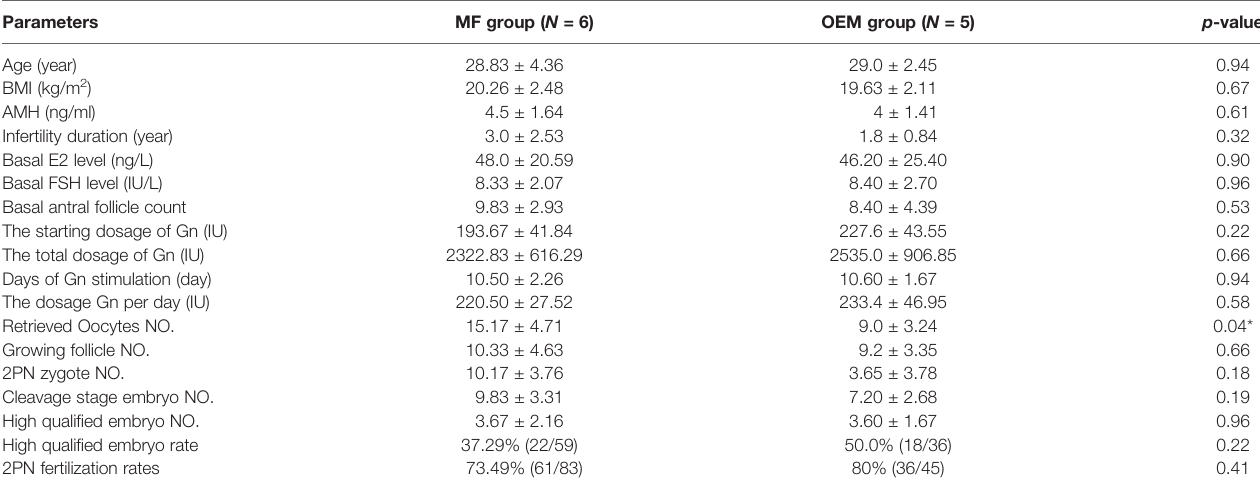
TABLE 1 | Clinical characteristics of infertile patients for GC